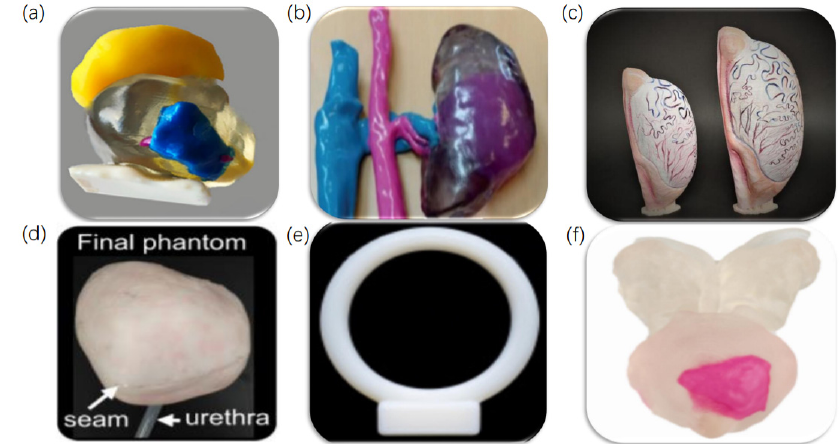
Figure 1. Three-dimensional-printed urological models for training and education: ( a ) 3D-printed prostate cancer model [7]; ( b ) 3D-printed kidney cancer model [8]; ( c ) 3D-printed testis model [9]; ( d ) 3D-printed bladder model [10]; ( e ) 3D-printed thermoplastic elastomer (TPC) urethra pessary model [11]; ( f ) 3D-printed prostate model [12].